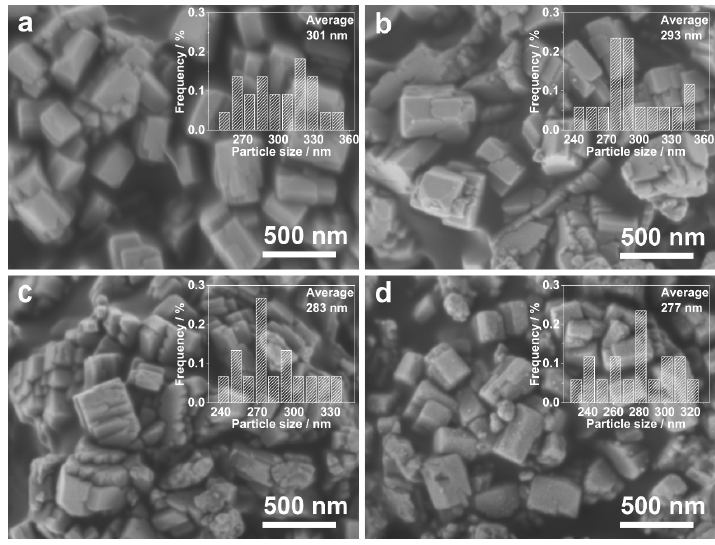
Figure 2. Scanning electron (SEM) images of ( a ) H-ZSM-5, ( b ) Fe/ZSM-5, ( c ) H-ZSM-5-ST and ( d ) Fe/ZSM-5-ST.